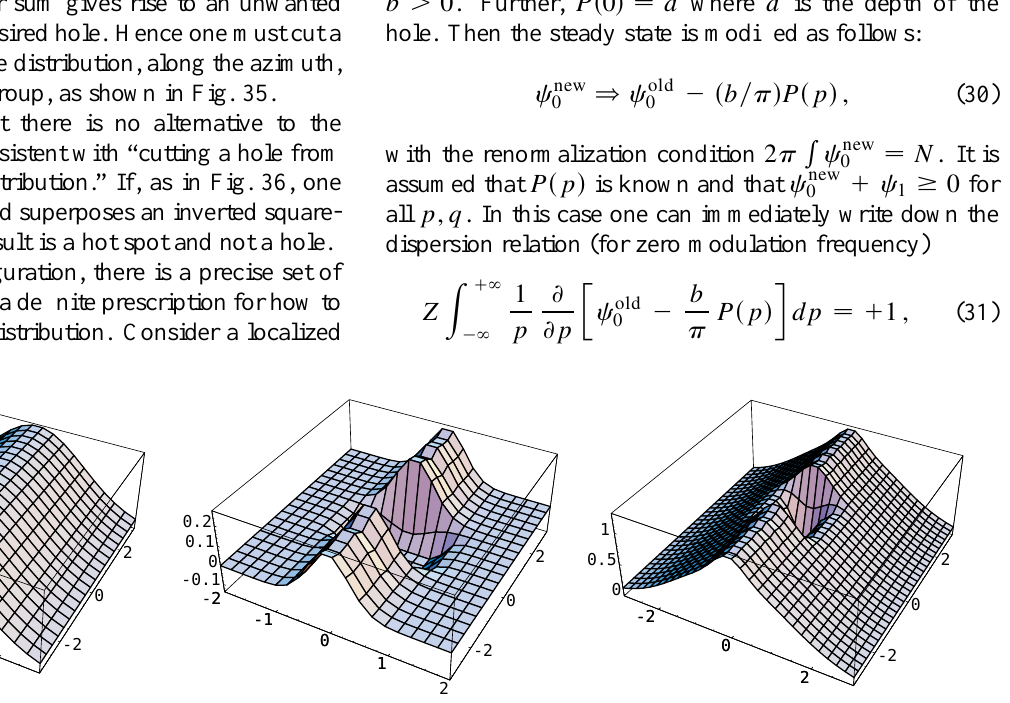
FIG. 34. (Color) Phase space distributions. Left to right: steady-state distribution c 0 ; square-wave perturbation c 1 ; c 0 1 c 1 has a hole and a ridge.